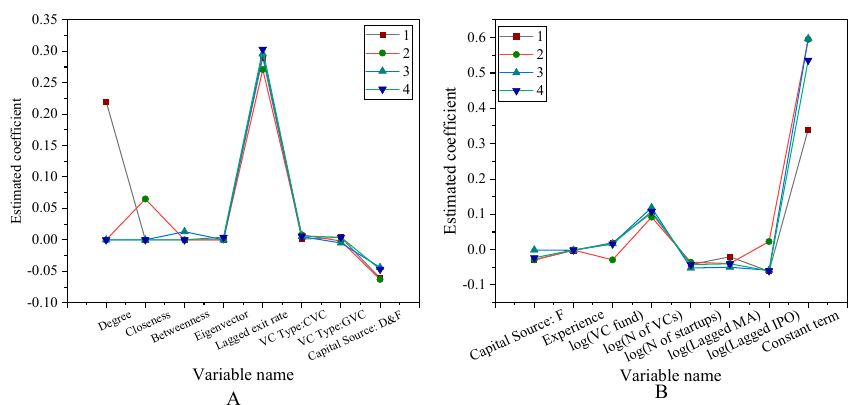
Figure 11. Results of the performance persistence test for venture capital firms ( A ) The first eight variables. ( B ) Other variables.